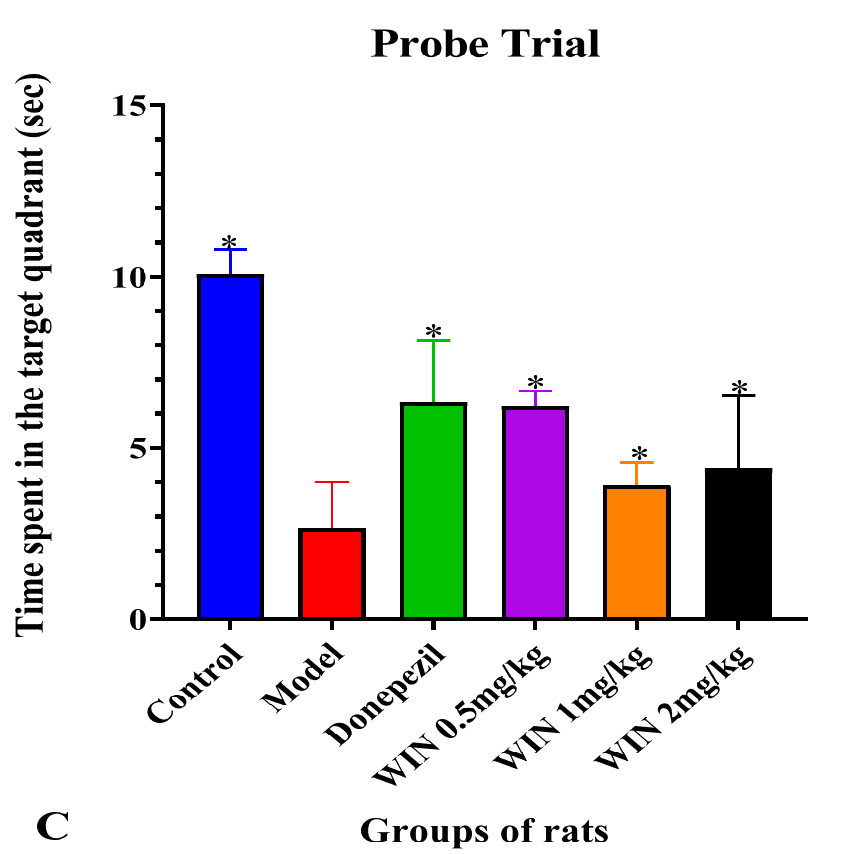
Figure 2. Assessment of spatial learning and memory of rats in Morris water maze. ( A ) Escape latency (s) during the 5 days trial to locate the hidden platform as part of the learning phase in the MWM. ( B ) The average distance traversed by the groups of rats over the 5 days trial. ( C ). The probe trial was conducted on day 6 after the trial phase when the hidden platform was removed. Rats were allowed to search for the platform in the target quadrant. The experimental groups include; Normal saline + Distilled water, (control), Model (AlCl 3 200 mg/kg + D -gal 60 mg/kg), positive control (Model + Donepezil 1 mg/kg, positive control), WIN low (Model + WIN55,212-2 0.5 mg/kg), WIN medium (Model + WIN55,212-2 1 mg/kg) and WIN high (Model + WIN55,212-2 2 mg/kg). Data were expressed as ± SEM for ( n = 6) rats per group. Statistical analysis was performed by two-way repeated measures ANOVA in ( A , B ), and One-way ANOVA in ( C ). * p < 0.05 vs. model